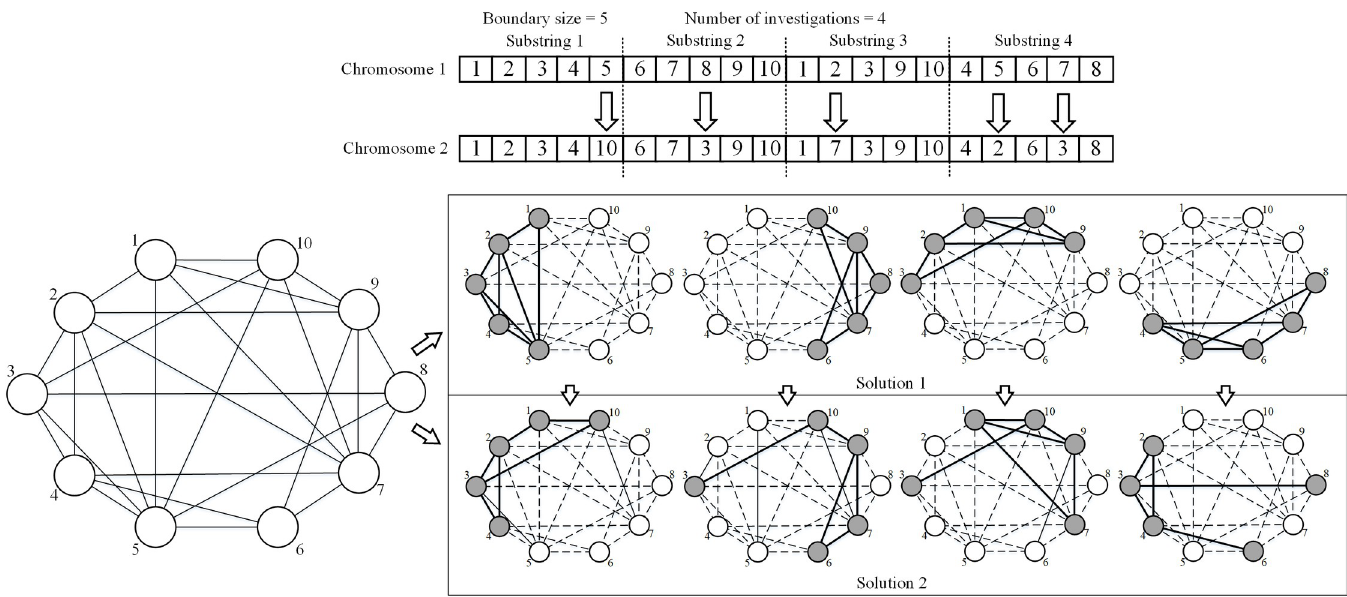
Fig 6. Illustration of the representation. The upper two chains denote two chromosomes consisting of genes. The lower left part is an input network, which consists of ten nodes. The lower right part is two solutions of extracted multiple subgraphs corresponding to the two chromosomes, where grey nodes represent the included nodes and white nodes represent the omitted nodes. The dashed line represents unobserved ties, while the bold solid lines represent the extracted ties.